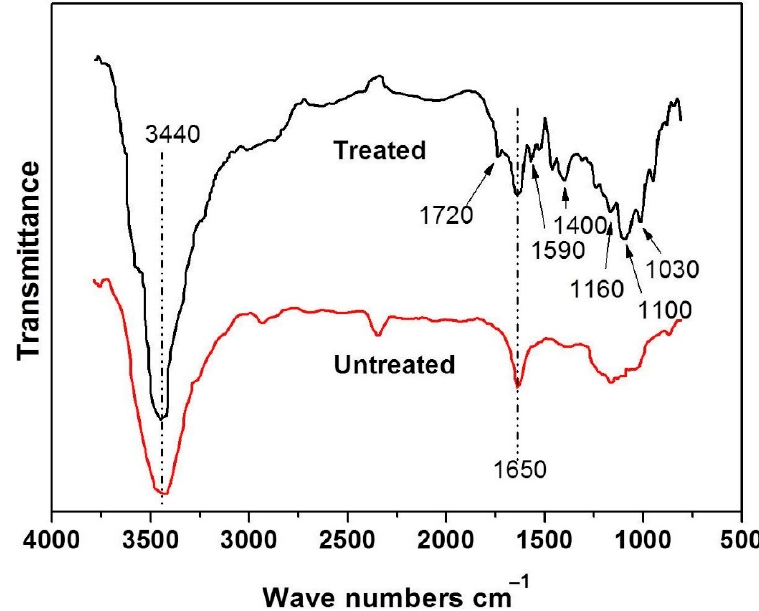
Figure 2. FT-IR spectrum of raw carbon fiber and treated carbon fiber.